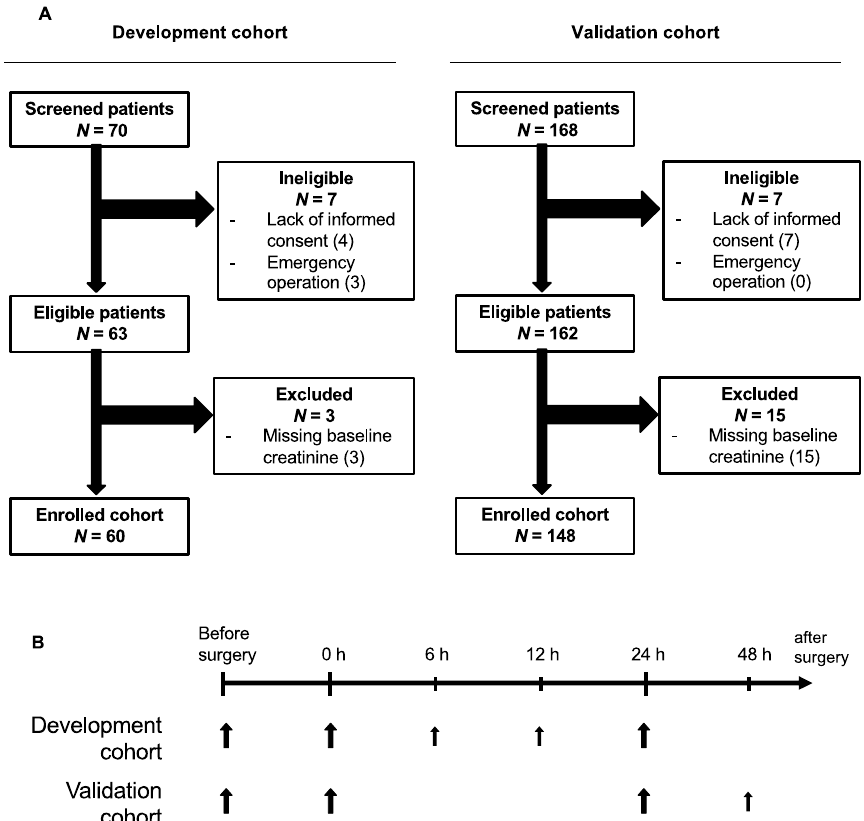
Figure 1. ( A ) Flowcharts of the two independent observational studies investigating SLPI as a biomarker of AKI after cardiac surgery. ( B ) The time points of sample collection for analysis. Larger arrows represent the collection of blood and urine, and smaller arrows represent the collection of blood only. SLPI, secretory leukocyte protease inhibitor; AKI, acute kidney injury.